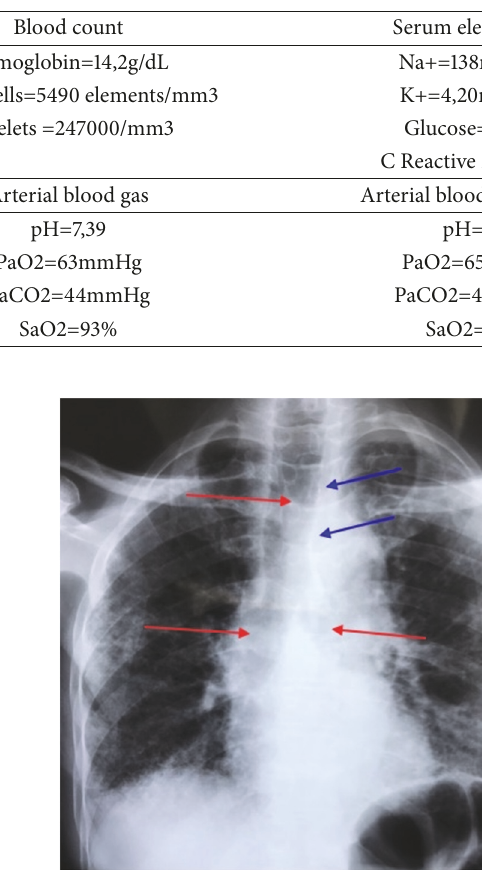
Table 1: Patient blood results.